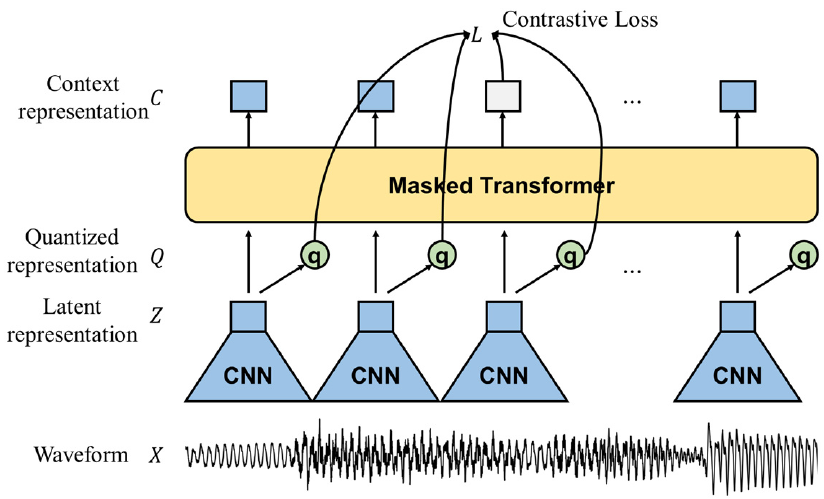
Figure 4. Network architecture for wav2vec2.0 and its pretraining stage based on contrastive loss.